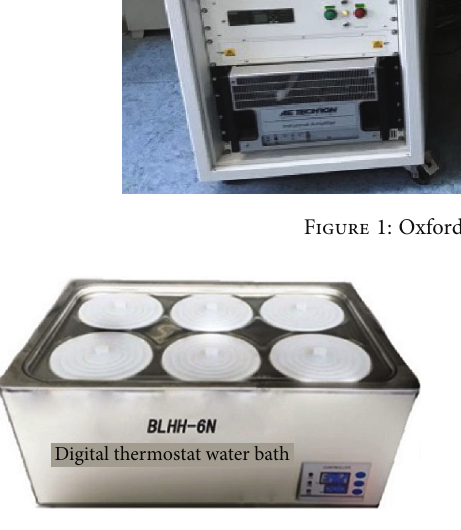
Figure 2: Water bath heating